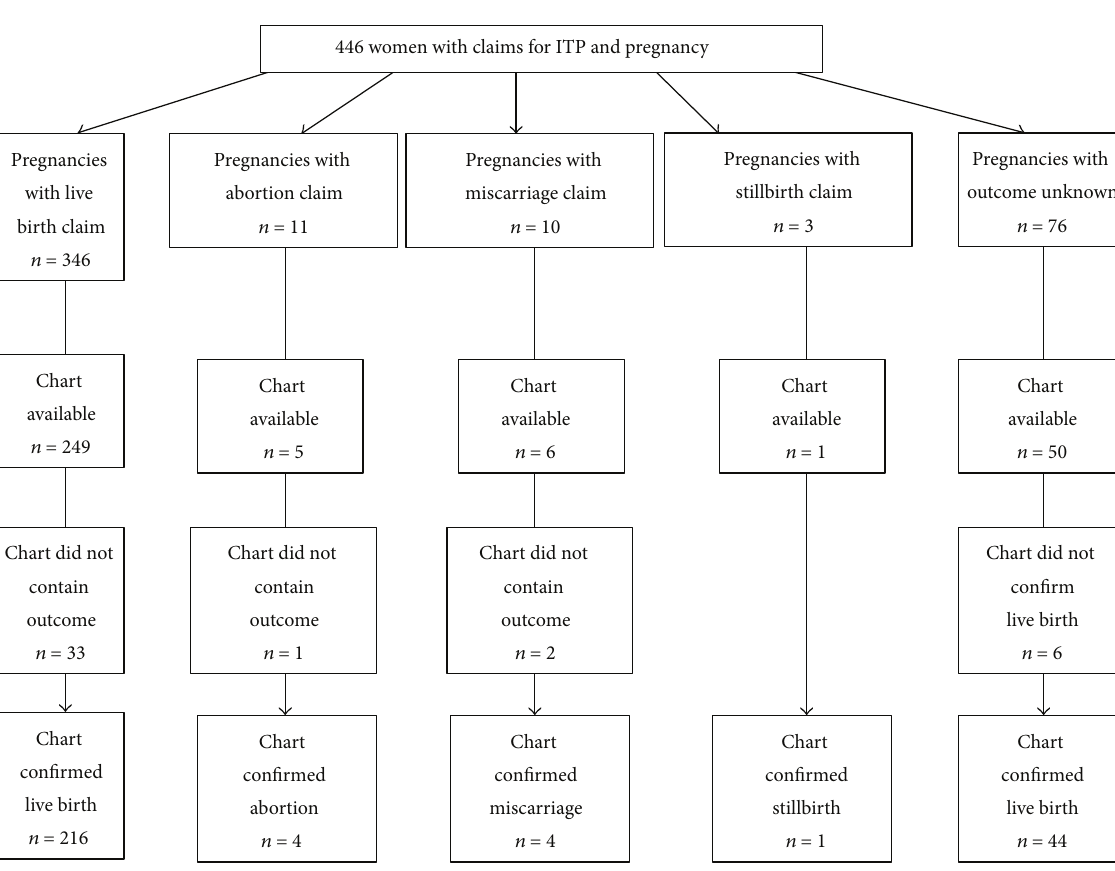
Figure 1: Chart review results of claims for pregnancy